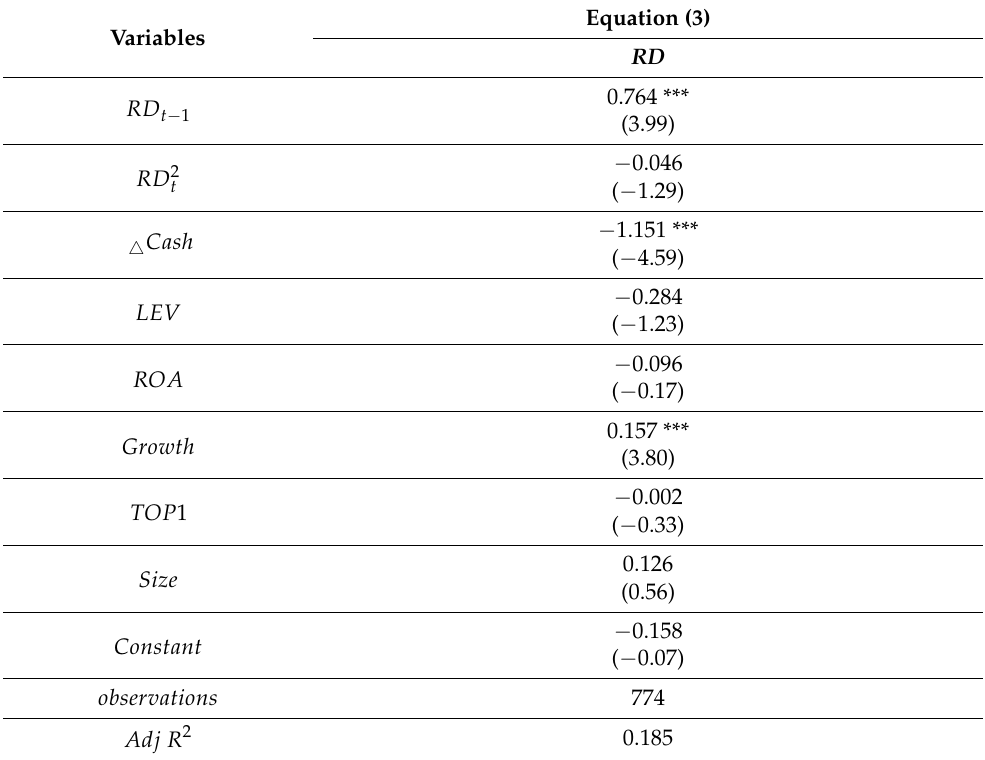
Table 3. The results of R&D investment smoothing behavior of pharmaceutical manufacturing